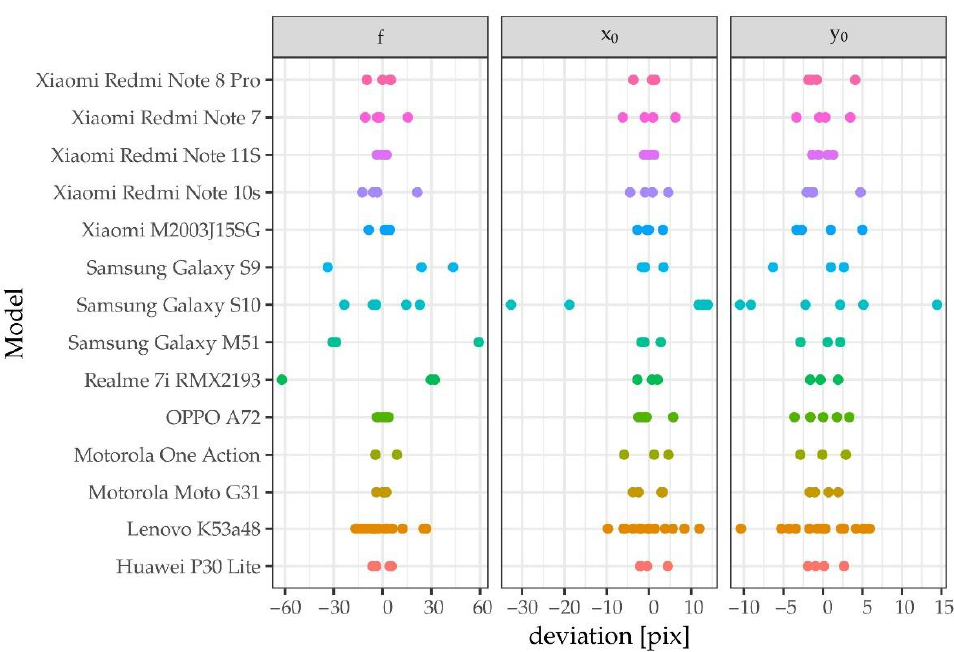
Figure 3. Stability of IO of all tested Models. The deviation was calculated as distance from the mean value. Table 3. Stability ranking for the tested